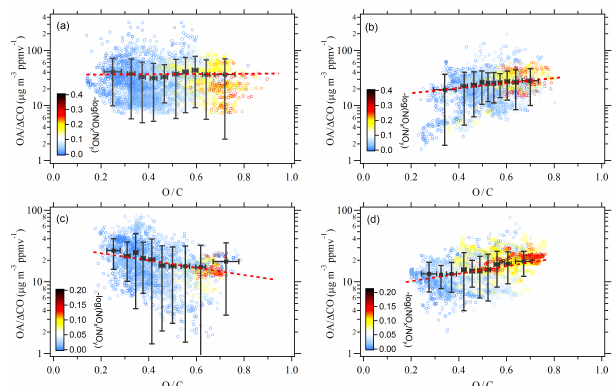
Figure 9. Scatterplots of OA /(cid:49) CO ( (cid:49) CO = CO-0.1) ratios vs. O / C atomic ratios in OA during the (a) spring, (b) summer, (c) autumn, and (d) winter observations. The OA /(cid:49) CO ratios are in the range of 1st and 99th percentile. The scatterplots are colored by the parameter − log(NO x / NO y )